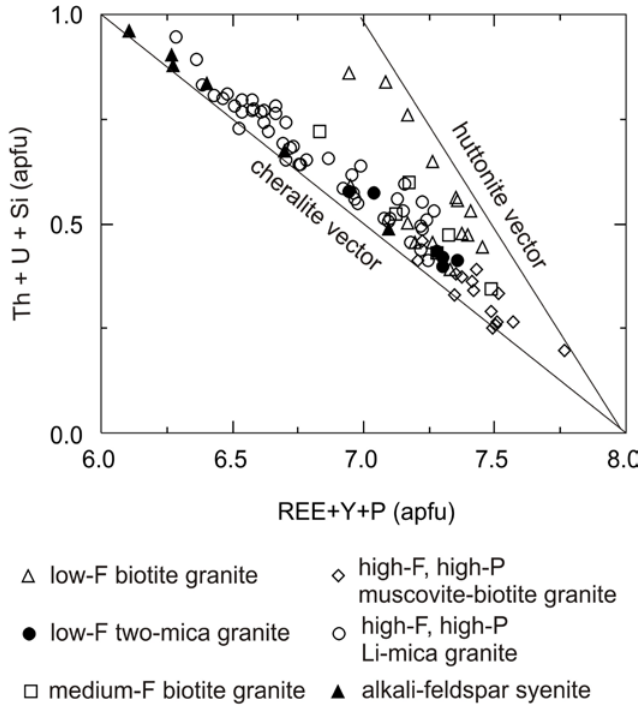
Figure 8. Monazite composition vectors of monazite from the Krudum granite body.